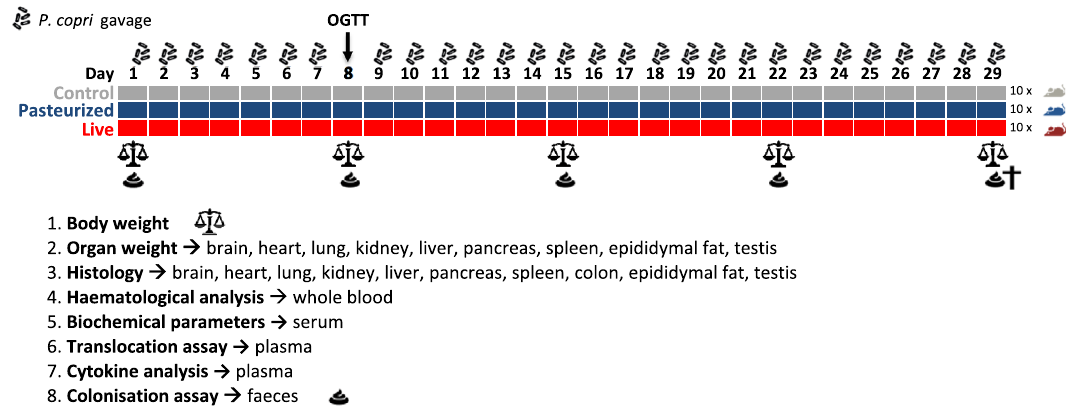
Figure 2. Experimental setup of the mouse study. This figure has been created using Excel office 365 (office. com). The icons were obtained from the following sources: ‘https:// pngim age. net/ poop- icon- png-3/’ by perfectly posh and ‘https:// www. icons db. com/ black- icons/ scales- icon. html’ by Icons8.com, Creative Commons Attribution-NoDerivs 3.0.